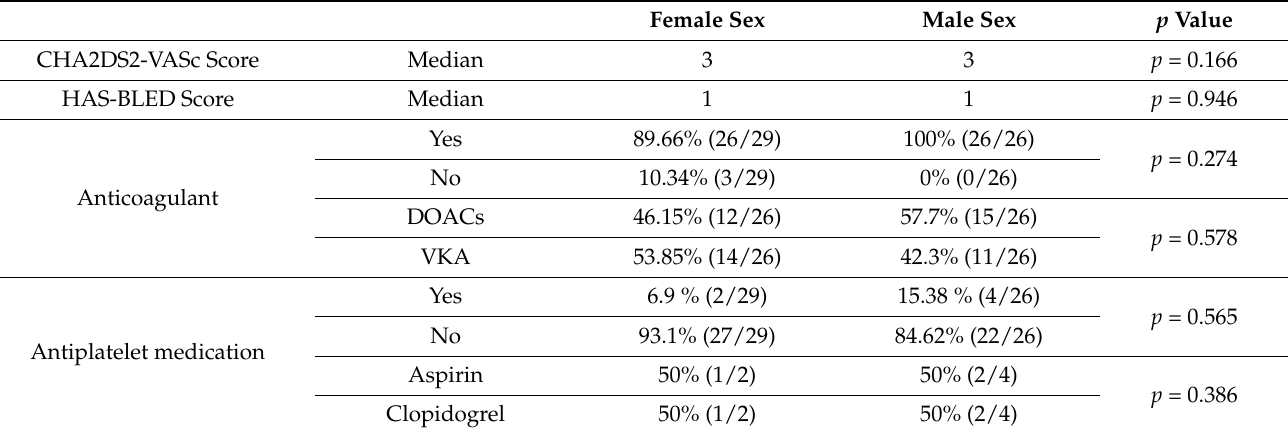
Table 3. Aspects related to the treatment used to prevent thromboembolic events.